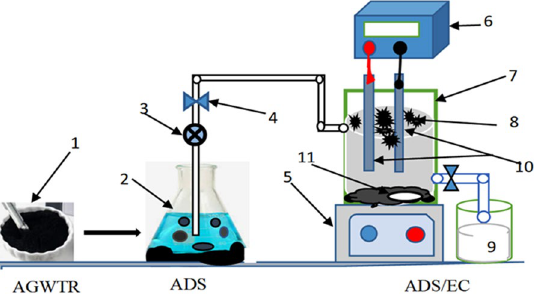
Figure 1. The apparatus layout used in the experiments: (1) AGWTR, (2) ADS Vessel; (3) pump; (4) control valve; (5) Stiller/Agitator; (6) direct current power source; (7) electro electric cell; (8) Flocs; (9) treated water in reception tank; (10) iron electrodes and (11) magnetic